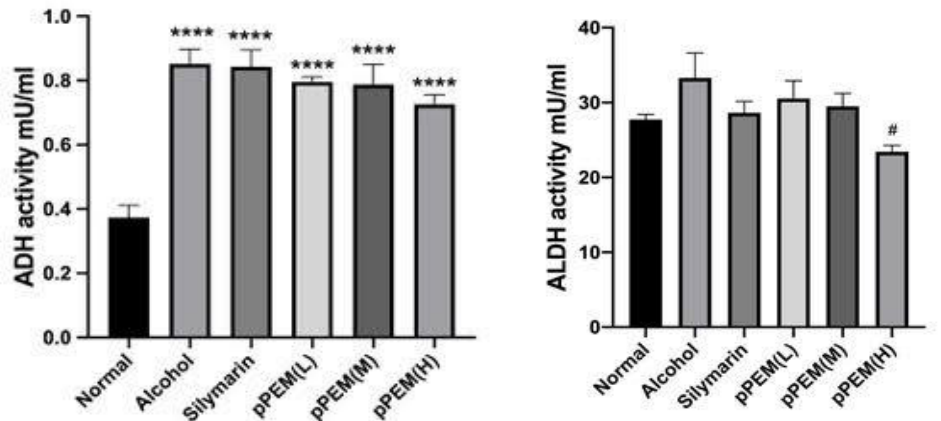
Figure 3. Effects of pPEM and silymarin on hepatic ADH and ALDH activities in alcohol-treated rats. The symbols in the figures show statistically significant differences among groups as follows: **** p < 0.001 vs. Normal Group; # p < 0.05 vs. Alcohol Group.